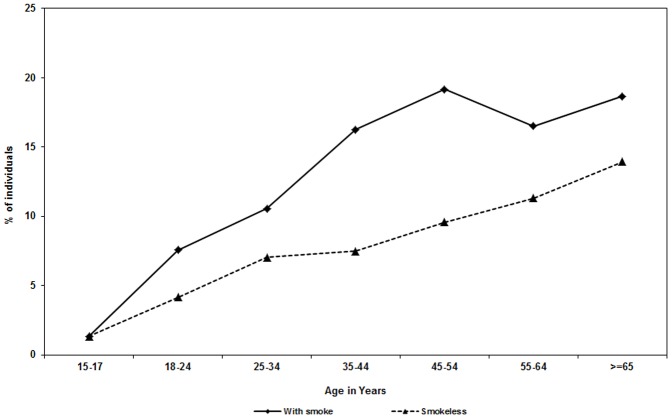
Prevalence of tobacco use by age.